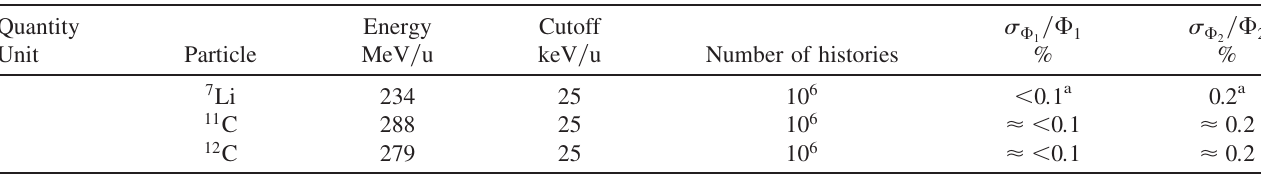
TABLE I. The physical, numerical, and statistical parameters related to the simulations. The simulations take into account Gaussian range straggling, multiple scattering, and nuclear reactions. The relative standard deviations, (cid:4) statistical uncertainties of the calculated fluence in the simulation. Type 1 here relates to the relative standard deviation in the plateau region and type 2 in the Bragg peak region.